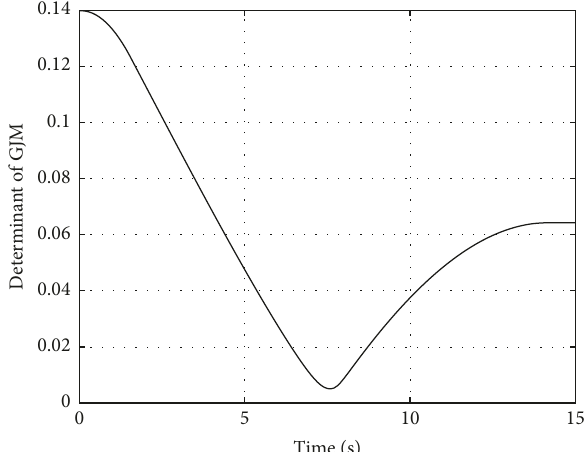
Figure 5: Determinant of GJM.